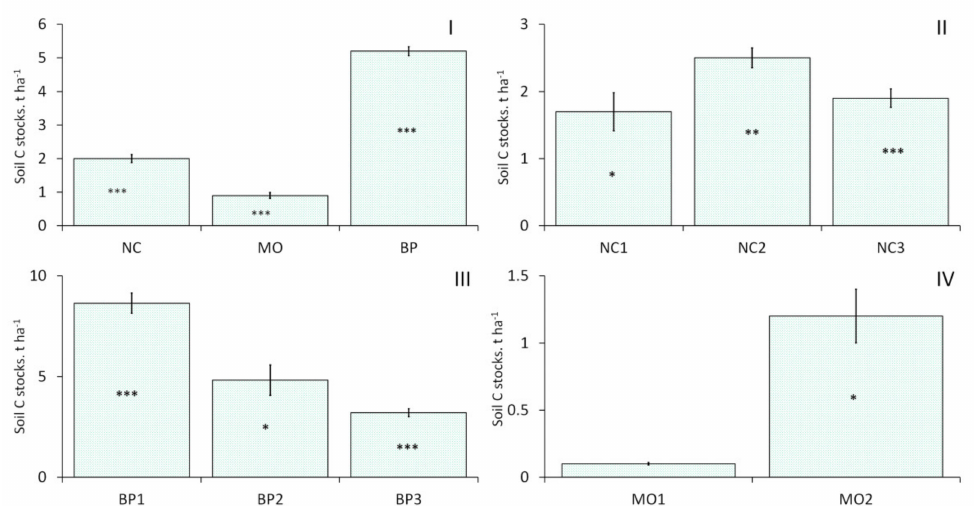
Figure 3. Soil carbon stocks in soil organic horizon (FH-layer) in ( I ) forests of three areas NC— Northwest Caucasus (n = 99), MO—Moskva-Oka plain (n = 69), BP—Bryansk Polesie (n = 83). ( II ) Forest types in NC: NC1—hornbeam–aspen (n = 30), NC2—hornbeam–fir–beech (n = 36), NC3— beech–fir (n = 33). ( III ) Forest types in BP: BP1—pine (n = 22), BP2—pine–broadleaf (n = 22), BP3—broadleaf–spruce (n = 39). ( IV ) Forest types in MO: MO2—spruce–broadleaf (n = 30),